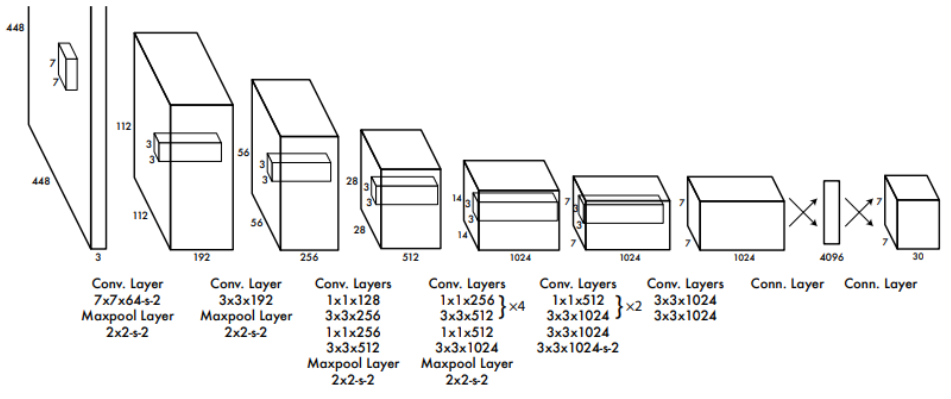
Figure 16. The architecture of YOLO [147].